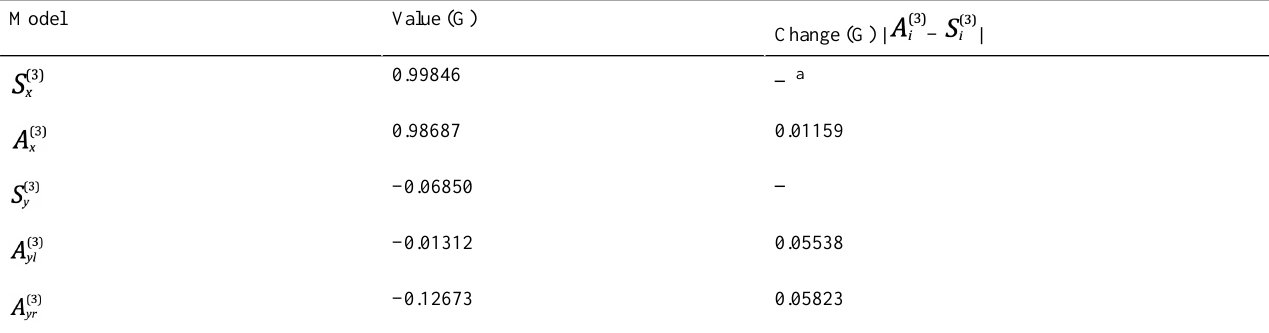
Table 3. Measurement results of user number 3 based on orthopedists’standards.